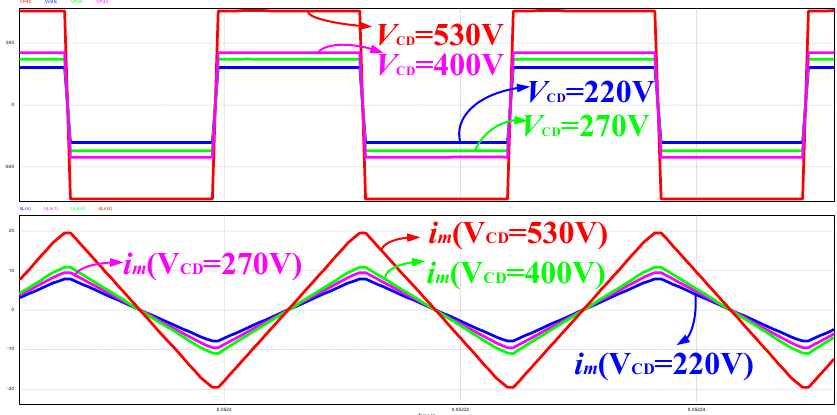
Figure 14. Simulation waveform of magnetizing inductor current under different V CD values.